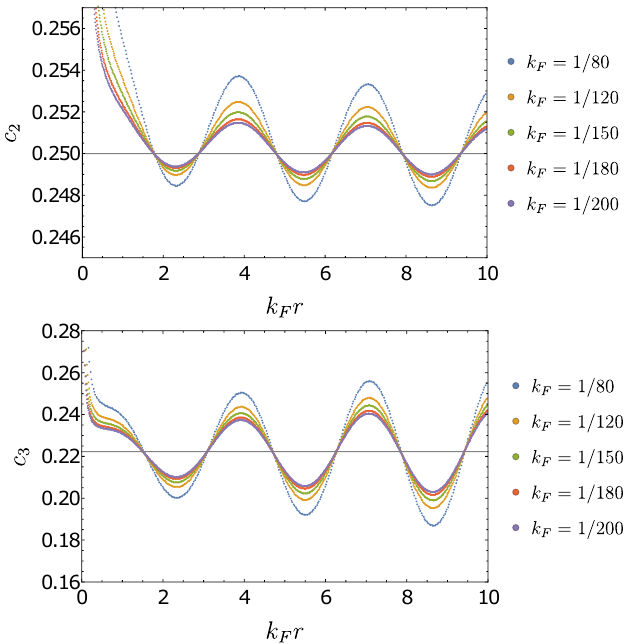
Figure 3 . c 2 and c 3 functions for a chiral fermion at finite density. The continuum limit corresponds to k F → 0 for k F r finite. The amplitudes of oscillations vanish in this limit, and the results converge to (4.5). Note the scale values in the c n